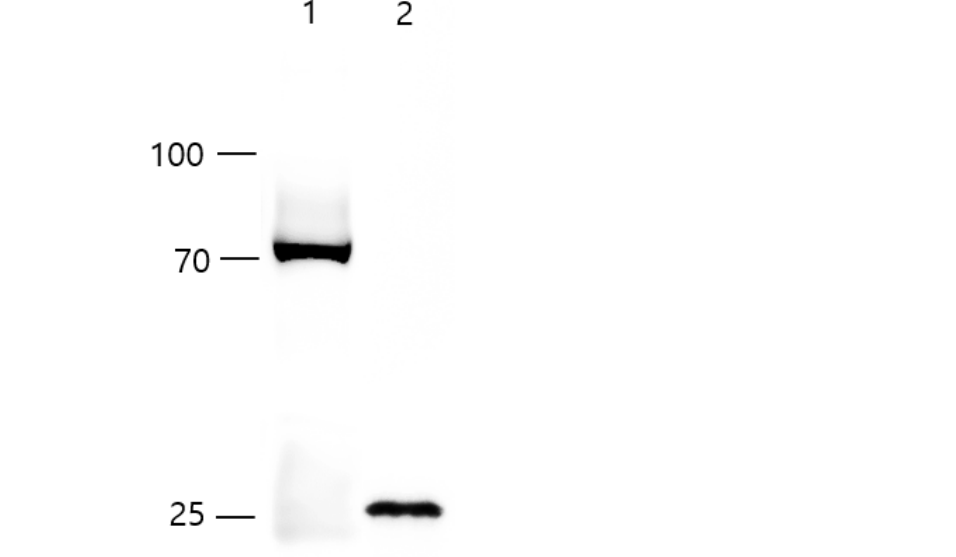
Figure 1. Molecular weight of the purified HEV-3-239-VLPs. The recombinant rabbit HEV whole capsid protein expressed by the E. coli system has a molecular weight of 72 kDa (lane 1). The monomer of HEV-3-239-VLP expressed in the baculovirus system has a molecular weight of 26 kDa (lane 2).